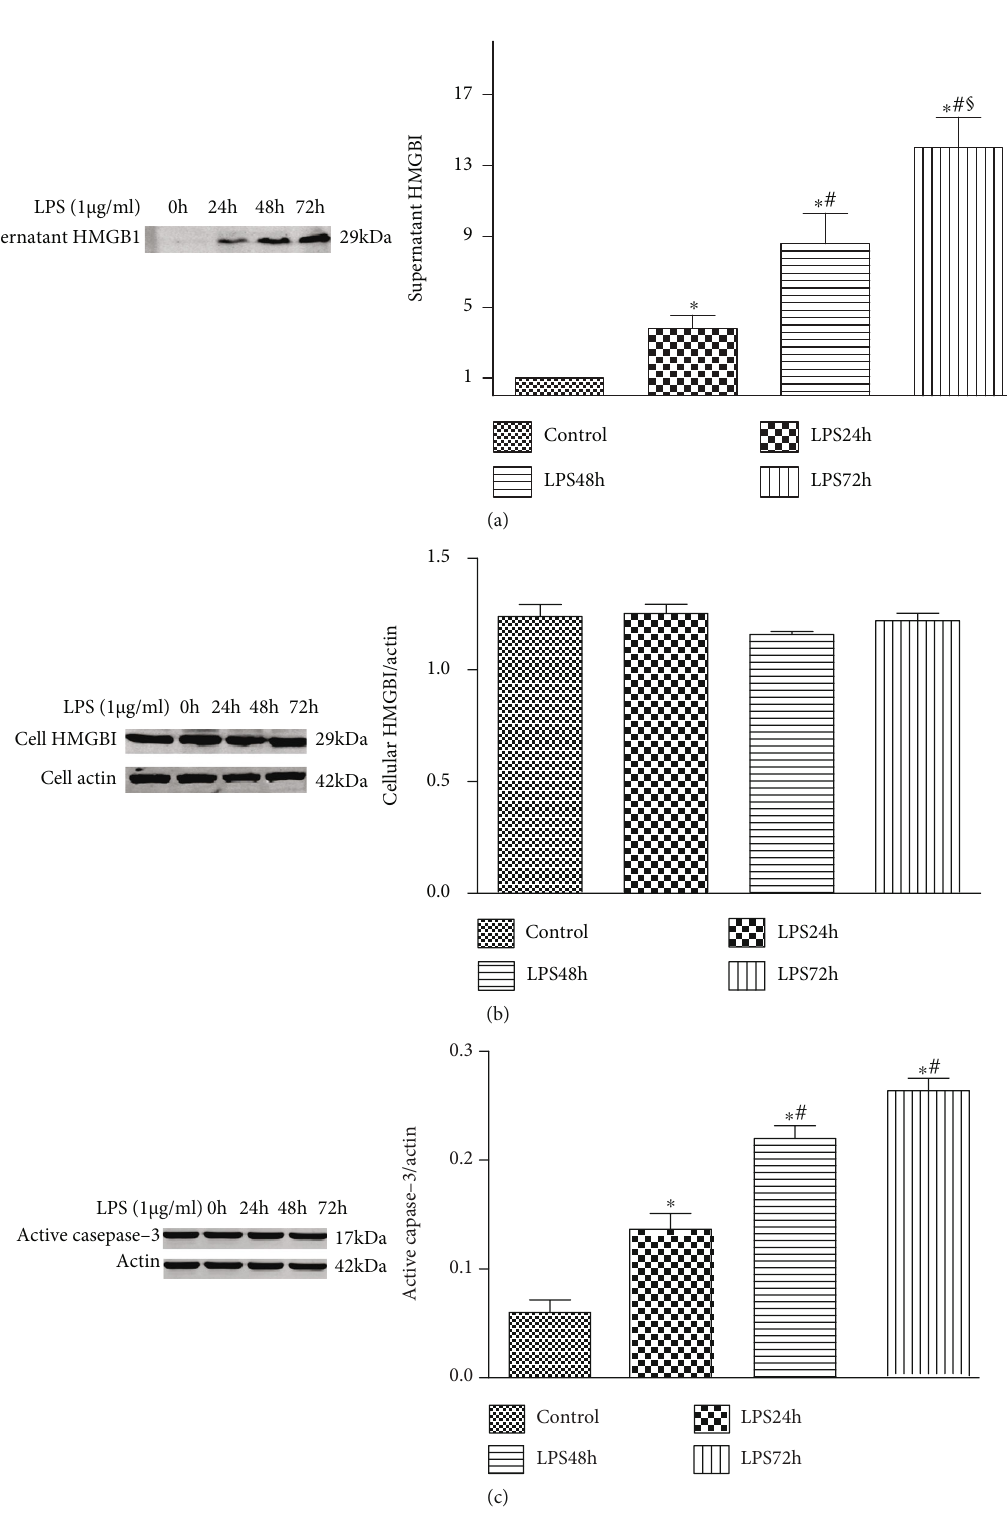
Figure 3: HMGB1 expression is increased in podocytes exposed to LPS. (a) Representative Western blotting analysis of supernatant HMGB1 expression after exposure to LPS for di ff erent durations (0, 24, 48, and 72 h). (b) Representative Western blotting analysis of cell HMGB1 expression after exposure to LPS for di ff erent durations (0, 24, 48, and 72 h). (c) Representative Western blotting analysis image of active caspase-3 expression after exposure to LPS for di ff erent durations (0, 24, 48, and 72 h). ∗ P < 0 : 05 compared with the control group; # P < 0 : 05 compared with the 24 h group; § P < 0 : 05 compared with the 48 h